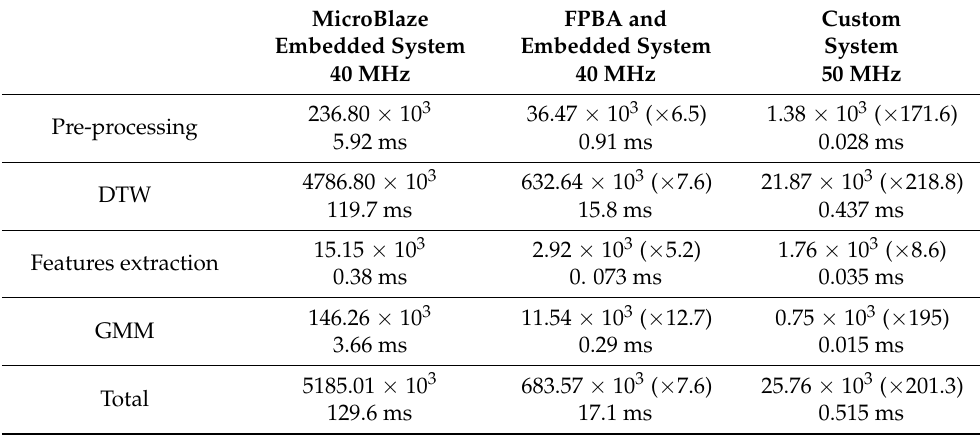
Table 2. Execution times, expressed in clock cycles (speed-up factor) and